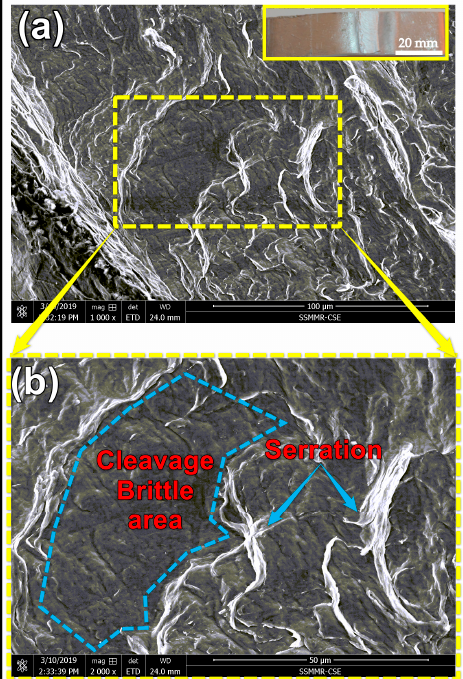
Figure 22. ( a ) The fracture morphology of the BT-FSW lap joint welded at travel speed of 200 mm/min and rotational speed of 600 rpm using Sq pin and ( b ) at a higher magnification.